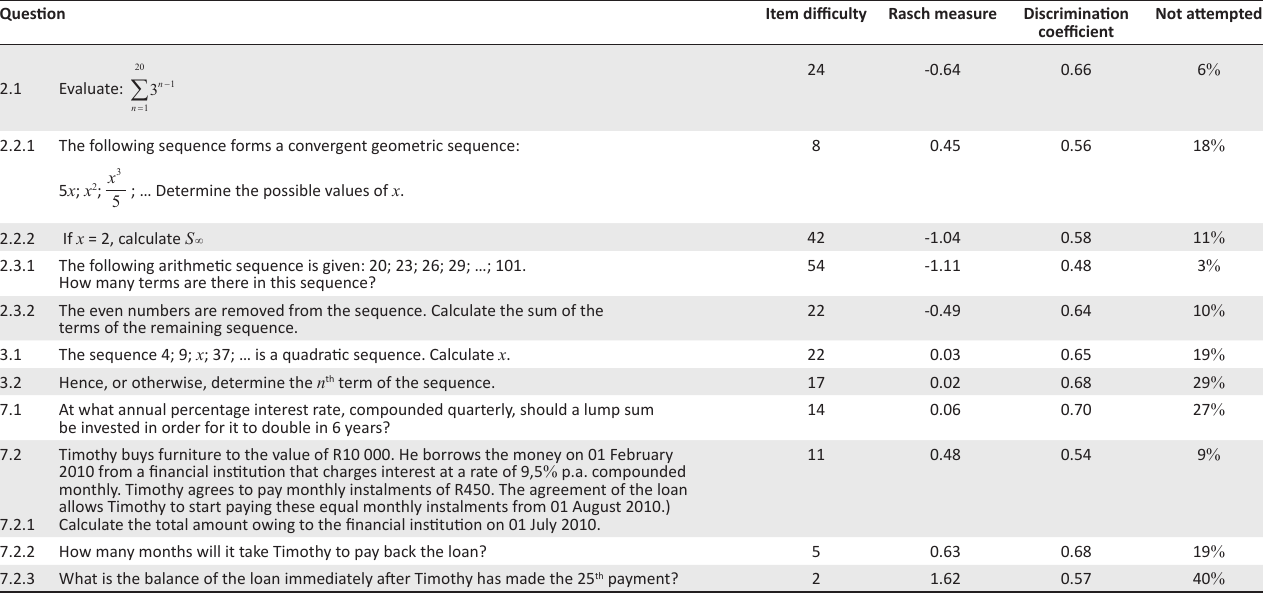
TABLE 2: Diagnostic statistics for the selected scripts and items.